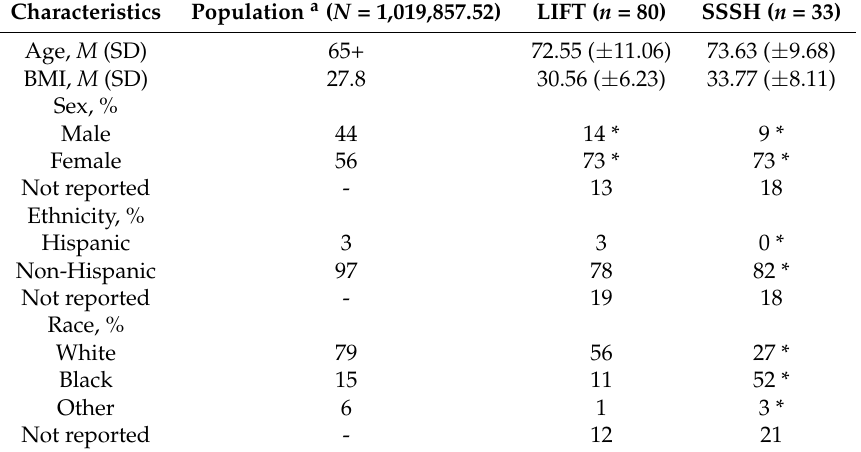
Table 2. Demographic information of total eligible population in Virginia (based on available census data) and demographic information of the sample participants enrolled in LIFT and